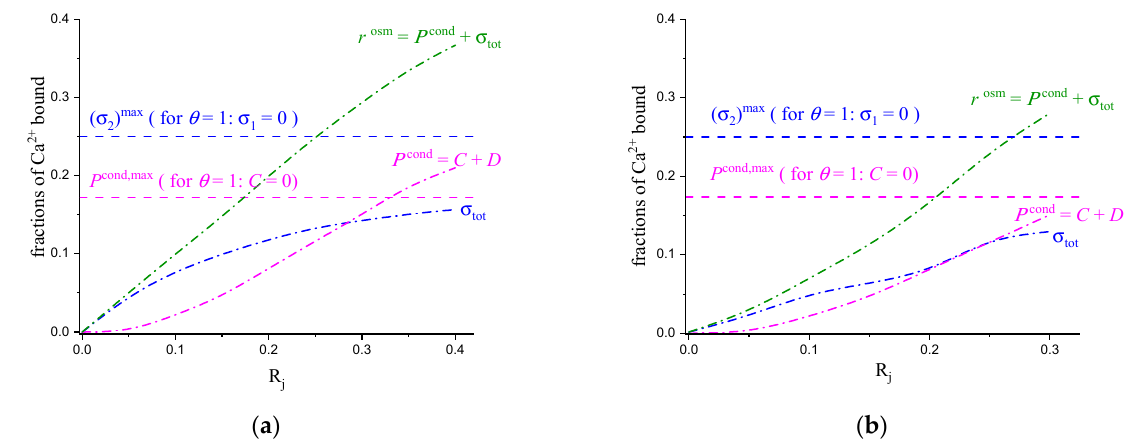
Figure 7. Dependence on R j of the various fractions of bound calcium ions to: ( a ) pectate and ( b ) alginate. For definitions, see text.